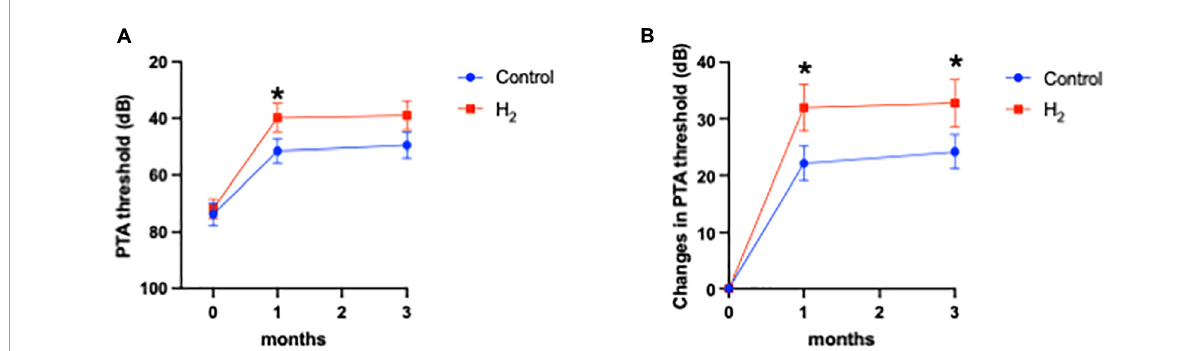
FIGURE2 Hearing outcomes. (A) PTA threshold. The PTA threshold in the H 2 group was significantly improved 1 month after treatment. However, this significant difference disappeared 3 months after treatment. * P < 0.05. (B) Changes in the PTA threshold. Changes in PTA threshold were significantly greater in the H 2 group at both 1 and 3 months after treatment. * P < 0.05.